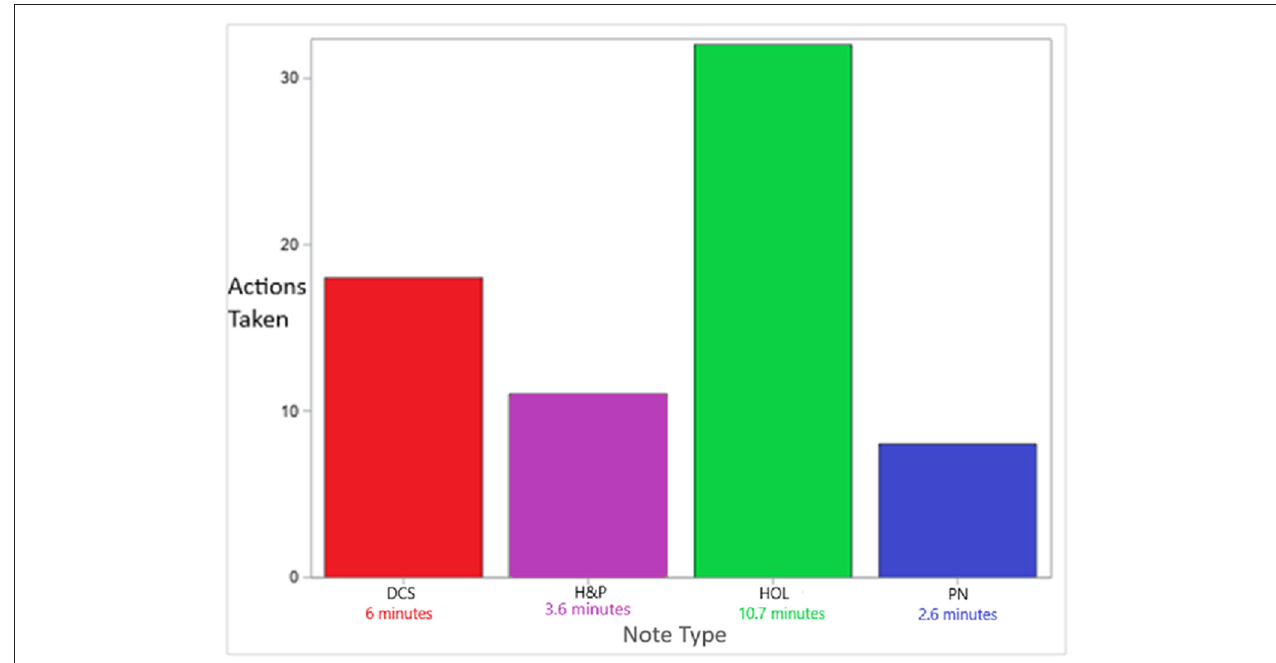
FIGURE 5 | Saved number of actions taken and time by minute per note type Significant pre vs. post difference p = 0.002 per Wilcoxon Signed Rank test for each note type.